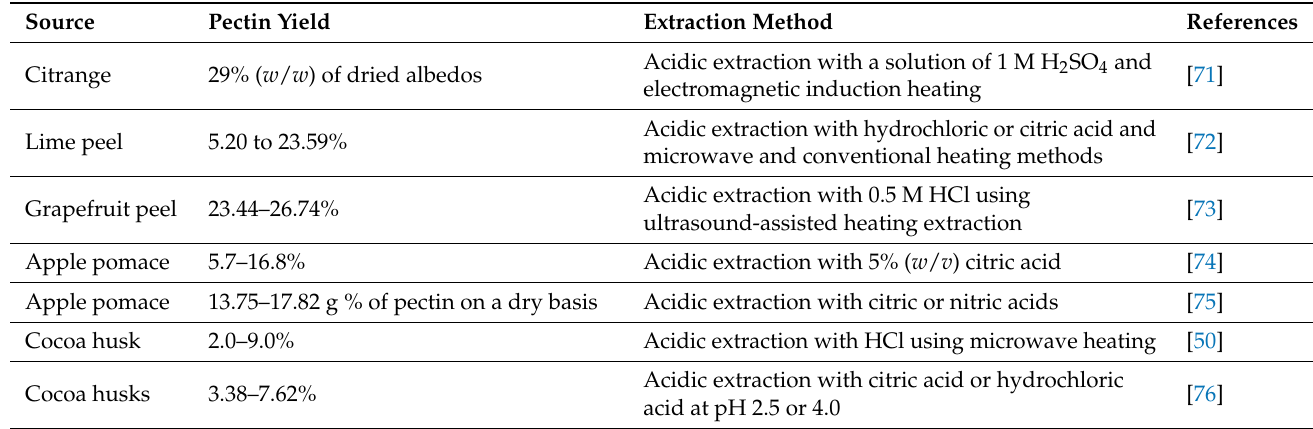
Table 1. Sources of pectin and the extraction